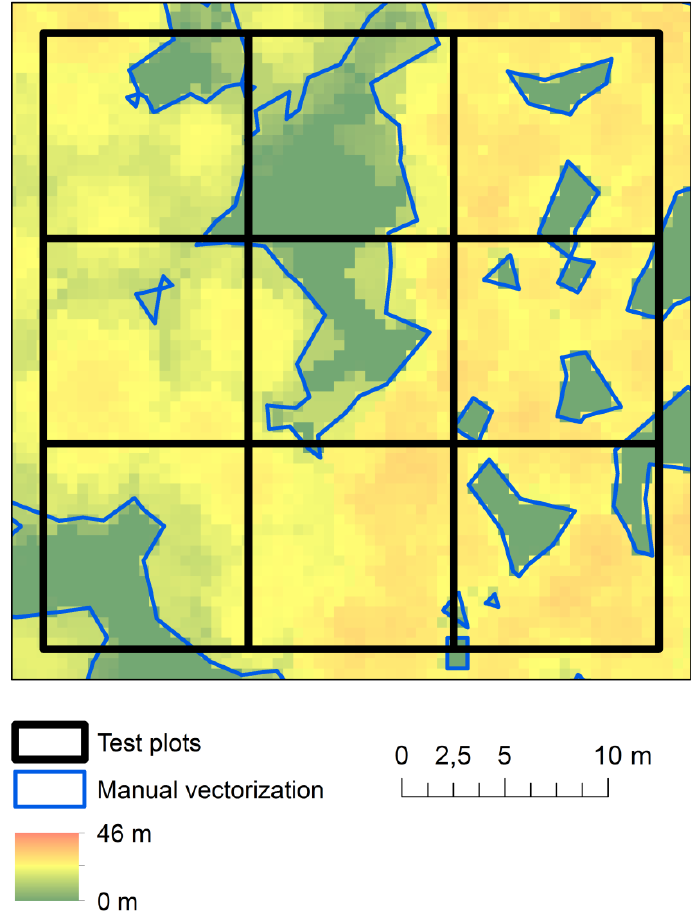
Figure 6. The example of the vectorization results.